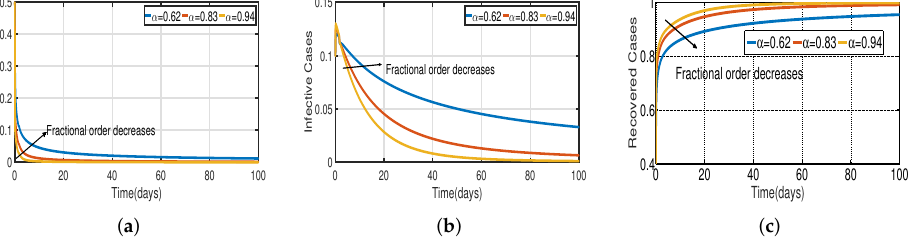
Figure 6. Vaccination model (2) with time delay τ = 1.5 ∈ [ 0, τ 0 ) . ( a ) Susceptible S ( t ) . ( b ) Infected I ( t ) . ( c ) Recovered R ( t )